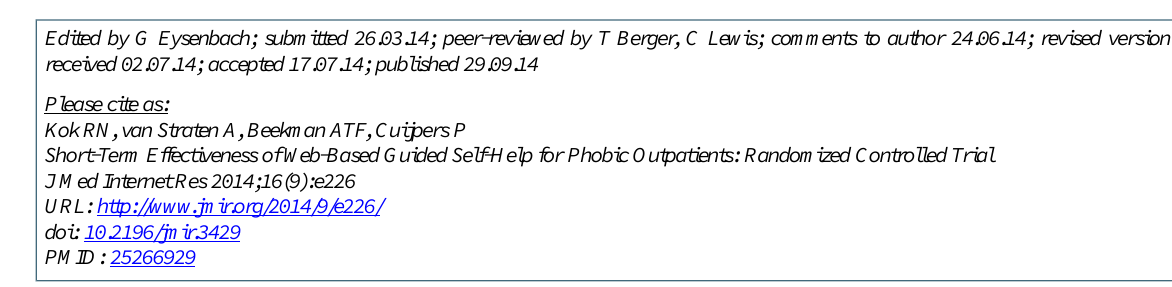
and license information must be included.